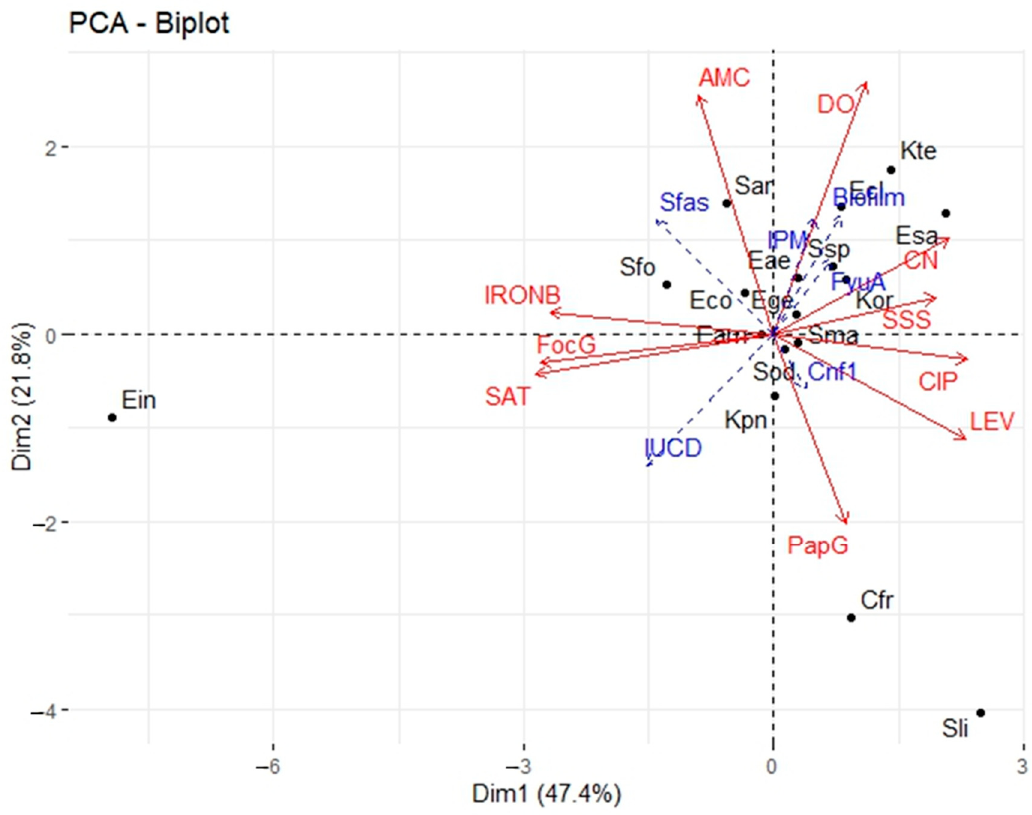
Figure 7. Scatterplot relating to the position of species with respect to axes 1 and 2. Legend: Cfr = C. freundii ; Eco = E. coli ; Eae = E. aerogenes ; Eam = E. amnigenus ; Ecl = E. cloacae ; Ege = E. gergoviae ; Ein = E. intermidius; Esa = E. sakazakii ; Kor = K. ornithinolytica ; Kpn = K. pneumoniae ; Kte = K. terrigena ; Sar = S. arizonae ; Ssp = S. spp ; Sfo = S. fonticola ; Sli = S. liquefaciens ; Sma = S. marcescens ; Sod = S. odolifera.